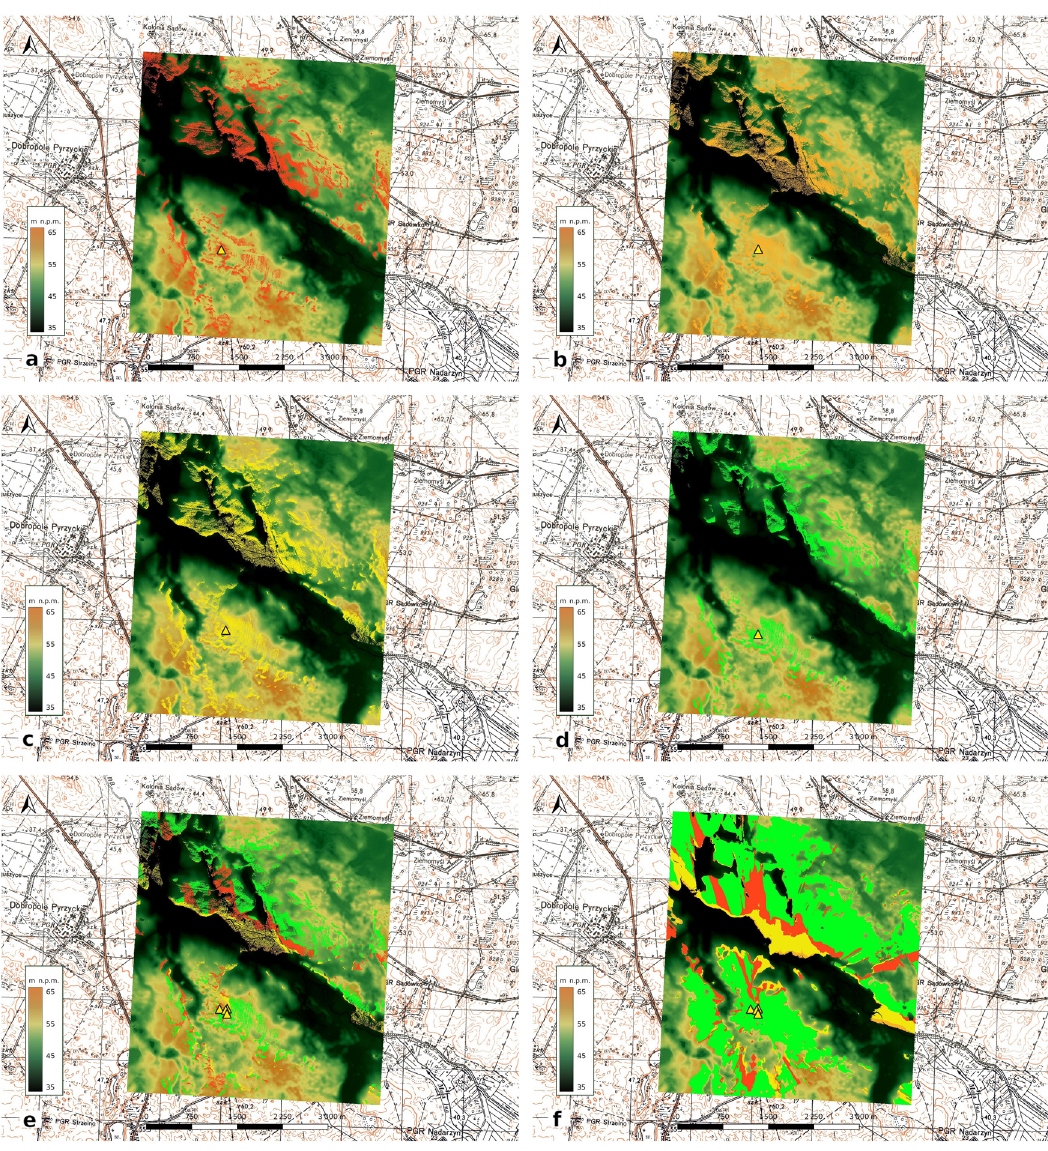
Figure 22: The P ł oszkowo megalithic group. The area visible from the tombs 1 ( a ) , 2 ( b ) , 3 ( c ) and 4 ( d ) . The area from which the P ł oszkowo group is visible ( e ) and the juxtaposed views of both parameters ( f ) ( M. Schiller )